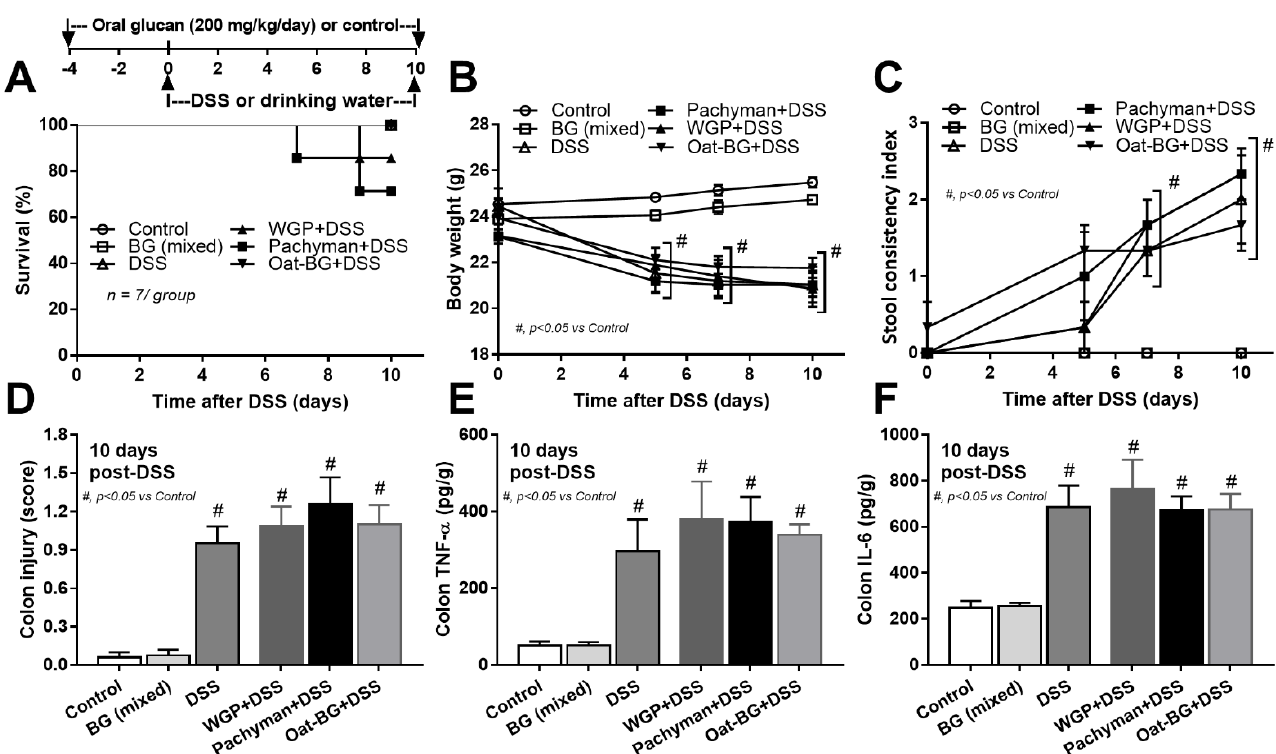
Figure 1. Schema of the experiments (A, upper part) and characteristics of mice with drinking water (Control) with or without oral β -glucan gavage using whole-glucan particles (WGP), Pachyman or Oat glucans (Oat-BG), which are combined into the BG (mixed) group, or dextran sulfate solution with or without several glucans. Survival analysis ( A ), bodyweight alteration ( B ), stool consistency index ( C ), colon injury score from Hematoxylin and Eosin (H&E) staining ( D ), and colon cytokines (TNF- α and IL-6) ( E , F ) are shown ( n = 6–8/group). #, p < 0.05 vs. Control as determined by ANOVA with Tukey’s analysis. Data from oral glucan-administered mice using different types of glucans were combined as BG (mixed) due to the nonsignificant difference between groups.